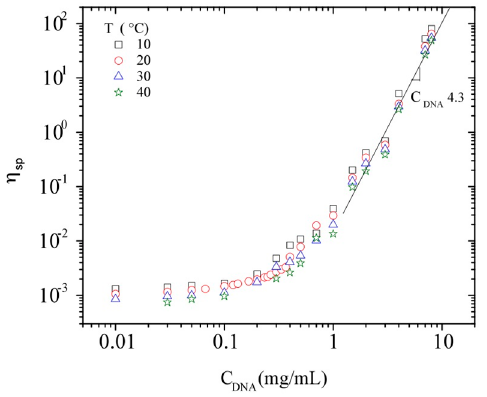
Figure 8. Specific viscosity at zero shear rate as a function of C DNA at 10, 20, 30, and 40 °C.